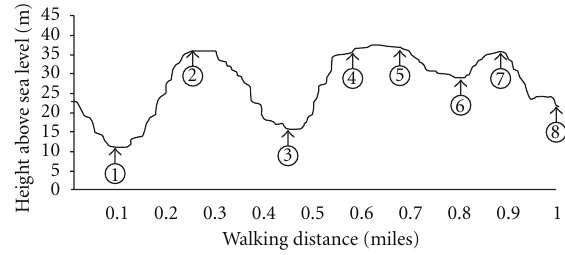
Figure 1: Topography of one-mile walk. Numbers 1 to 8 relate to the location (Stages) where data was